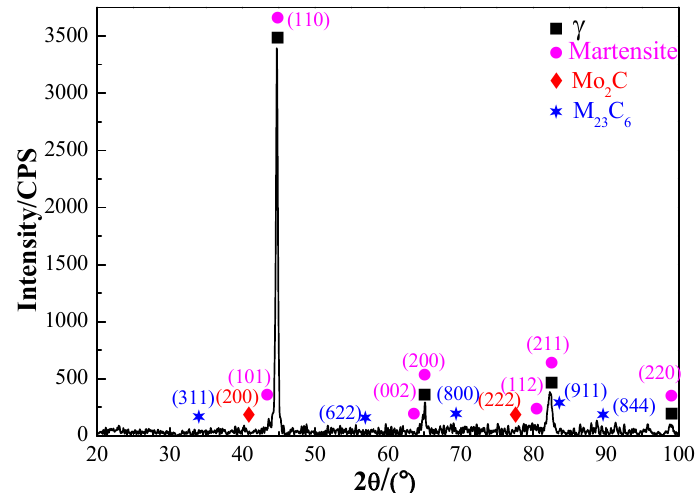
Figure 6. XRD of FeCrNiMoRE cladding layer.